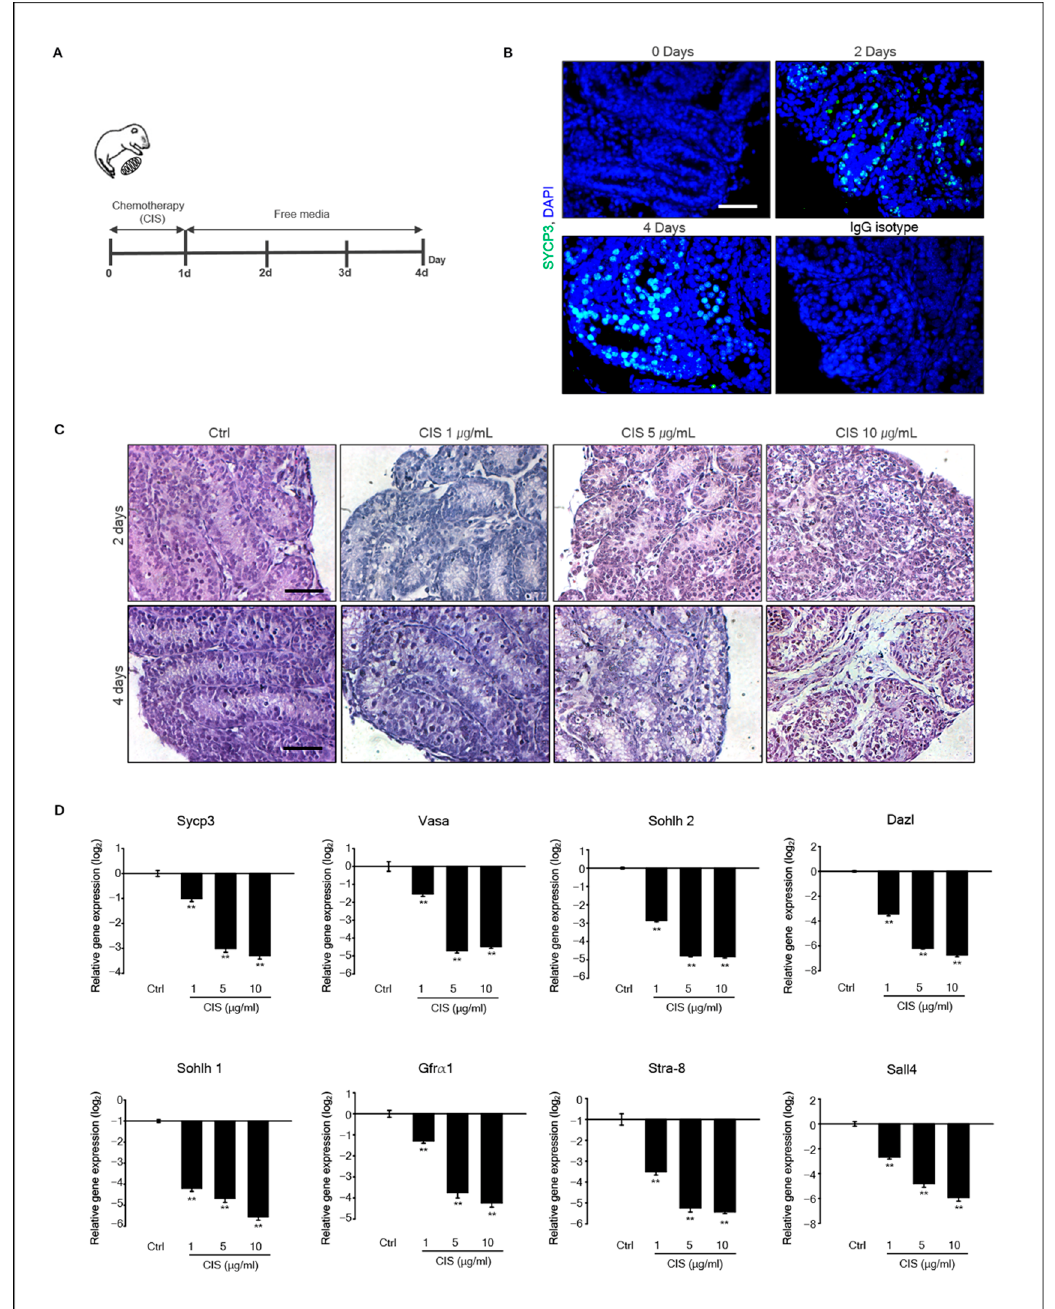
Figure 1. Morphological changes in MTFs induced by cisplatin and gene expression of germ cell marker in MTFs. ( A ) Experimental design diagram. MTFs derived from 5.5 d postpartum mice were cultured with cisplatin (1, 5, and 10 μ g/mL) for 1 d, and the medium was replaced with a cisplatin- free medium for 3 d. ( B ) Immunostaining of SYCP3 on cultured MTFs during 2–4 d. ( C ) Histological assessment using hematoxylin and eosin staining of 1–10 μ g/mL cisplatin-exposed MTFs cultured for 2, 3, and 4 d. Scale bars = 50 μ m; each image was observed at the same magnification. ( D ) Gene expression of germ cell markers in cisplatin-exposed MTFs. The expression levels of germ cell marker genes, Sycp3 , Vasa , Sohlh2 , Dazl , Sohlh1 , and Stra8 , and undifferentiated germ cell markers Gfra1 and Sall4 in the MTFs were determined using quantitative polymerase chain reaction (qPCR). Relative quantification of mRNA is shown using the mean and the standard error of the mean ( n = 5) at the log 2 scale. Data were analyzed using Student’s unpaired t -test, ** p < 0.01.